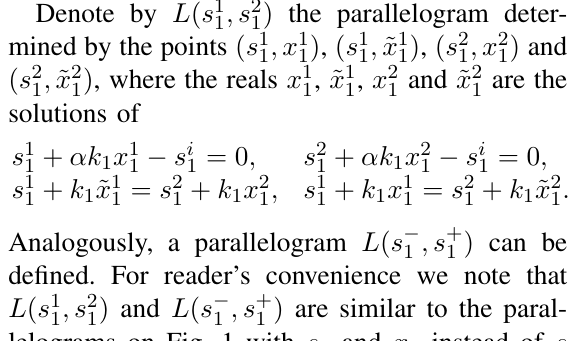
) , F = ( s − , ˜ x − ) , G = ( s + , x + ) , H = ( s + , ˜ x + ) ; the lines l 1 : s + k 3 x 2 = s i , 2 2 2 2